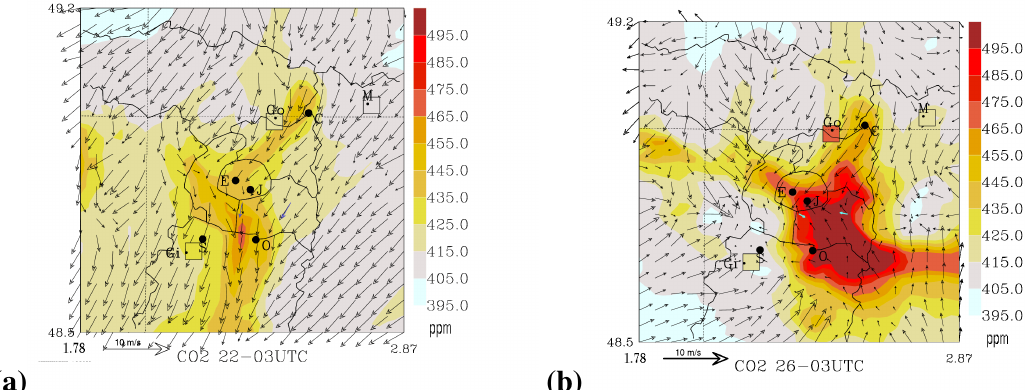
Fig. 15. Horizontal cross sections of CO 2 mixing ratio (in ppm) and predicted wind arrows (in ms − 1 ) near the ground for (a) March 22 at Fig. 15. Horizontal cross-sections of CO mixing ratio (in ppm) and predicted wind arrows (in m/s) near 2 03:00UTC, (b) 26 March at 03:00UTC. the ground for (a) March 22 at 03:00 UT , (b) 26 March at 03:00 UT . Fig. 15. Horizontal cross-sections of CO mixing ratio (in ppm) and predicted wind arrows (in m/s) near 2 the ground for (a) March 22 at 03:00 UT , (b) 26 March at 03:00 UT . 45 Table 6. Mean CO 2 mixing ratios (in ppm) for the 2 periods